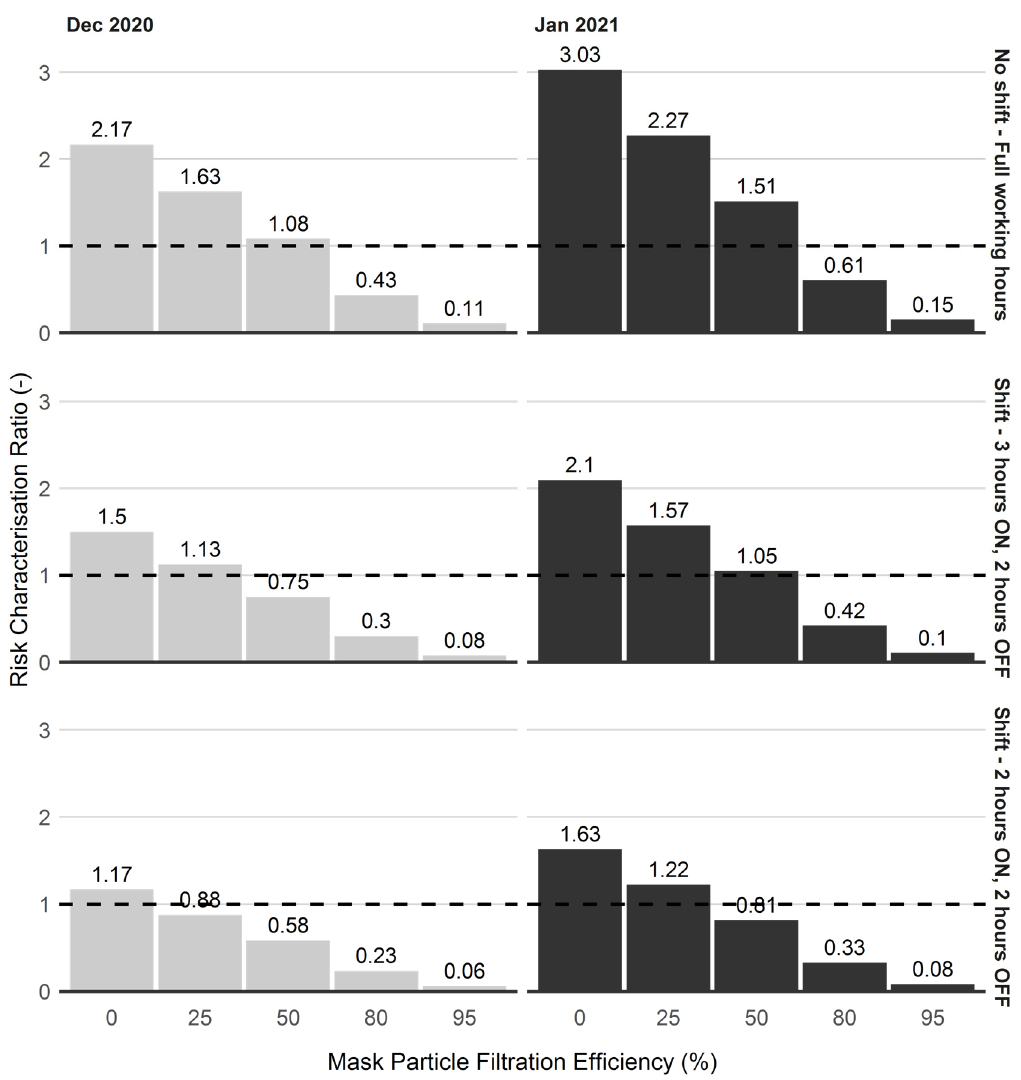
Figure 8. Effects of control interventions on occupational exposure risk over the period of socio- religious (24–30 December 2020) and academic (20–26 January 2021) events.